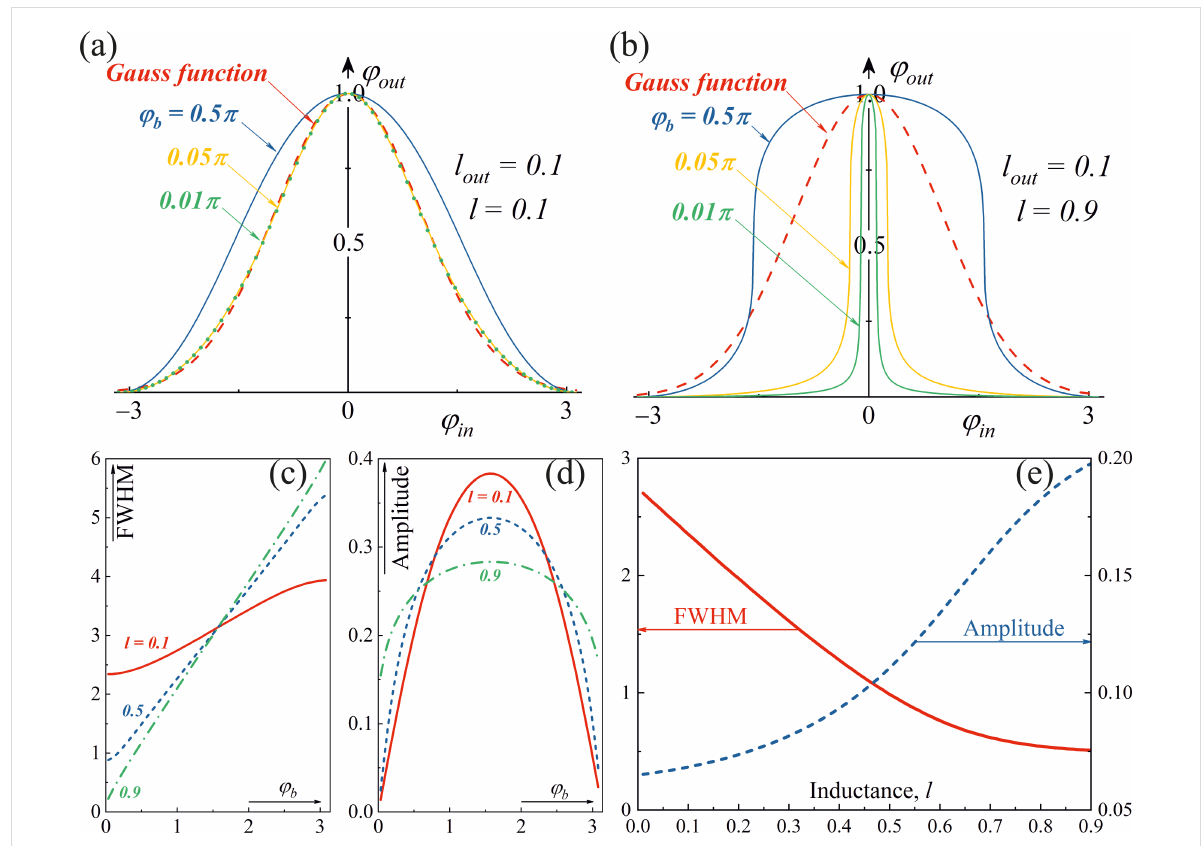
Figure 2: Transfer functions (normalized) and their main characteristics for the Gauss-neuron. (a, b) Families of the normalised transfer functions depending on the magnitude of the bias flux φ b for various pairs of inductances l and l out : (a) l = 0.1, l out = 0.1; (b) l = 0.9, l out = 0.1. (c) Dependencies of FWHM and amplitude on the bias flux φ b of transfer functions for l = 0.1, 0.5, and 0.9 with l out = 0.1. (d) Dependencies of FWHM and amplitude on the inductance l for transfer functions of the Gauss-neuron at l out = 0.1 and φ b = 0.05 π .